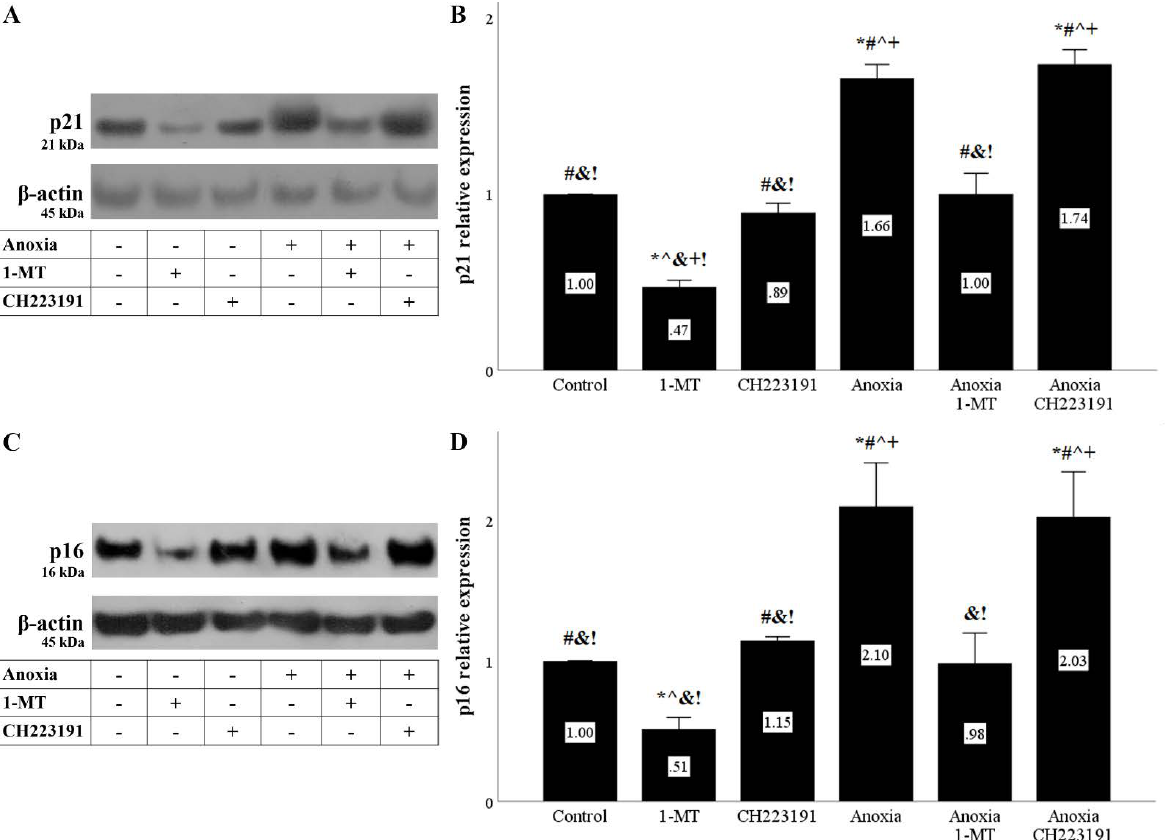
Figure 7. Anoxia upregulates the cell-cycle inhibitors p21 and p16, whereas inhibition of IDO prevents their